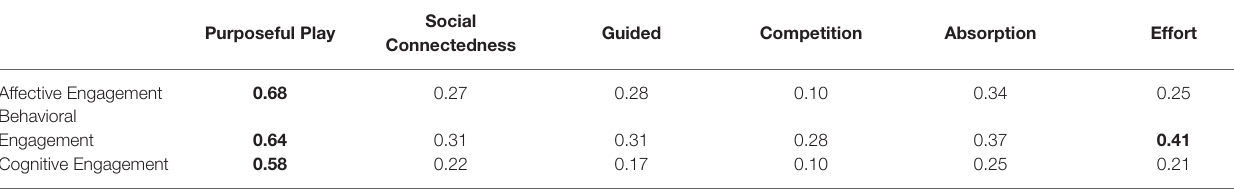
TABLE 6 | Correlations (Spearman’s Rho) between experienced gamefulness and dimensions of engagement in a learning experience. Social Purposeful Play Connectedness